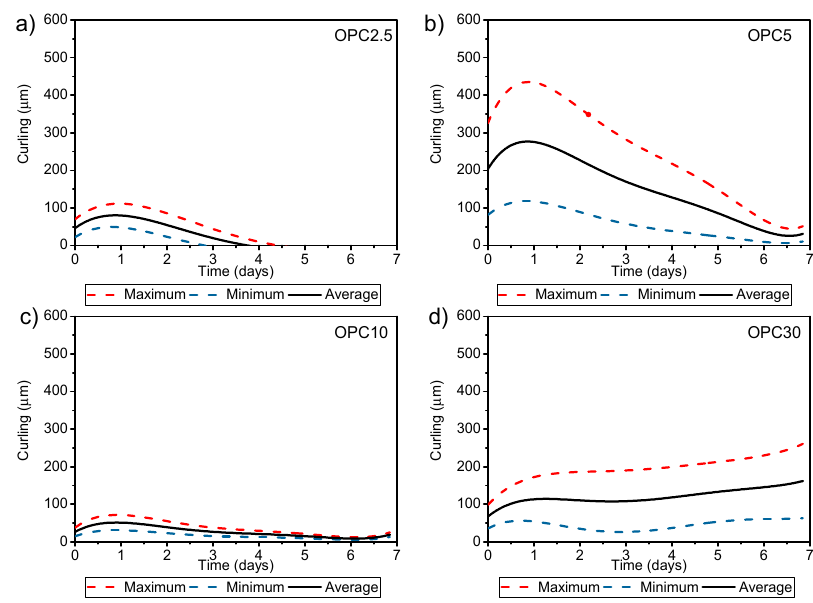
Figure 8. Curling over the time for binary mortars screeds. ( a ) OPC 2.5 mortar mix; ( b ) OPC 5.0 mortar mix; ( c ) OPC 10 mortar mix; ( d ) OPC 30 mortar mix.